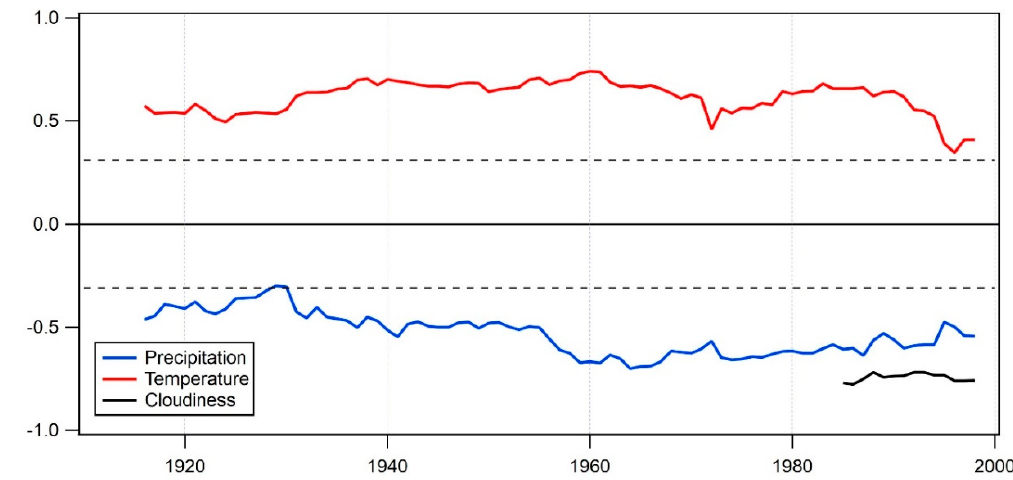
Figure 7. Temporal stability between δ 13 C Pinus chronology and June–August climate parameters, calculated as a 30-year moving correlation. Horizontal dashed line represents 95% probability threshold of the statistical significance of the Pearson’s correlation coe ffi cient.